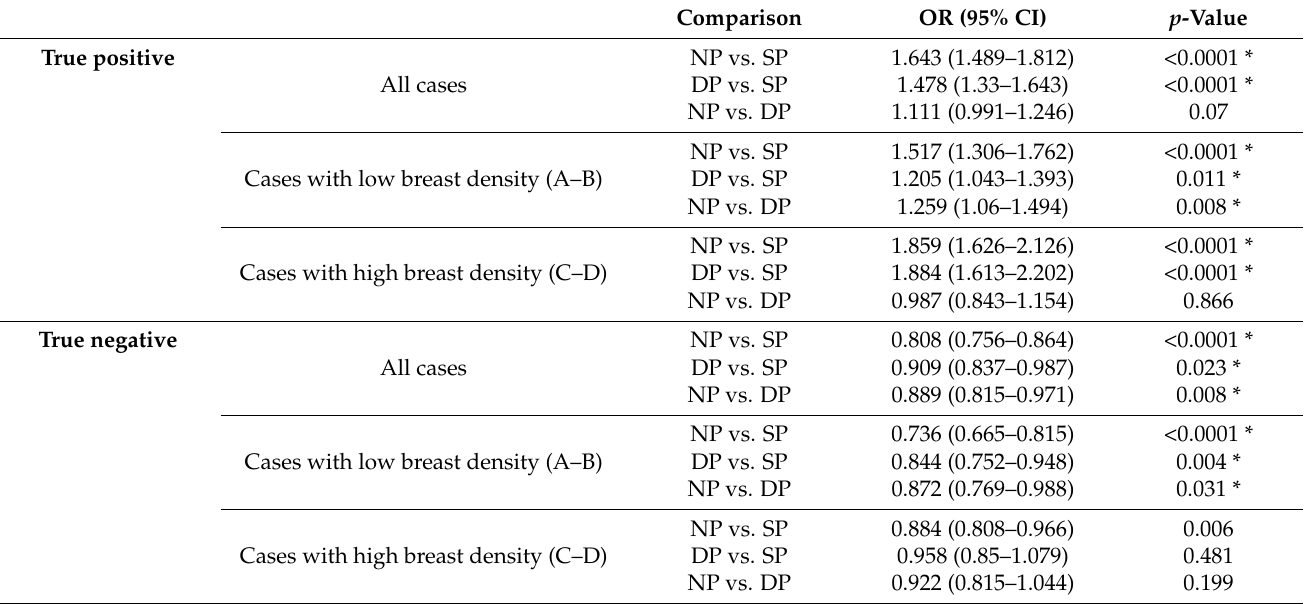
Table 4. Estimated Odds Ratio (OR) of true positive and true negative of mammograms in comparison of cases without prior images, with prior images from the same vendor and with prior images from different vendor. Comparison OR (95% CI) p